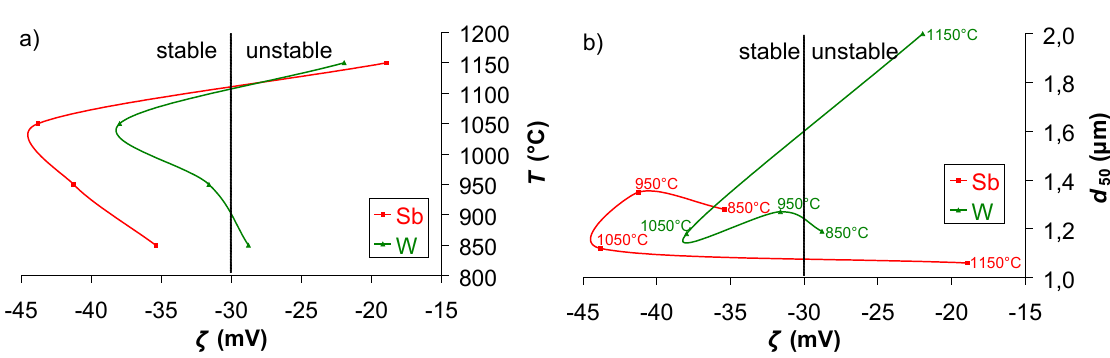
Figure 5. Dependence of electrokinetic potential of pigments Ti